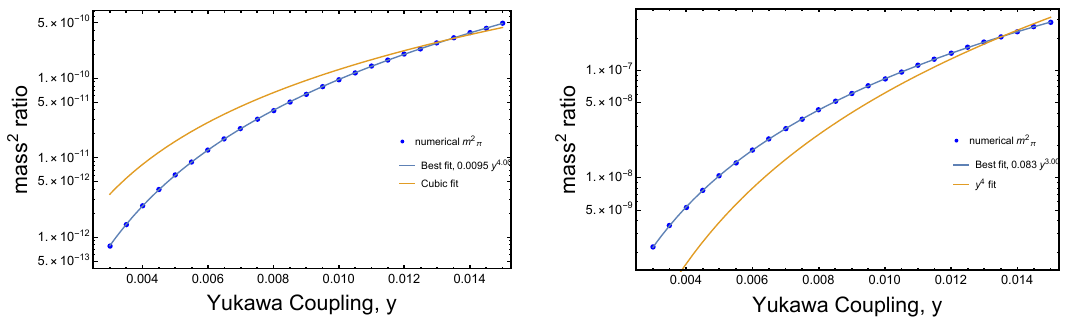
Figure 3. The ratio of the square of the heavier discrete NGBs’ mass to the square of the radial mode’s mass. For simplicity we take f 2 = 1 , (cid:21) = 1 ; (cid:22) = 1. In the left panel, we have 2